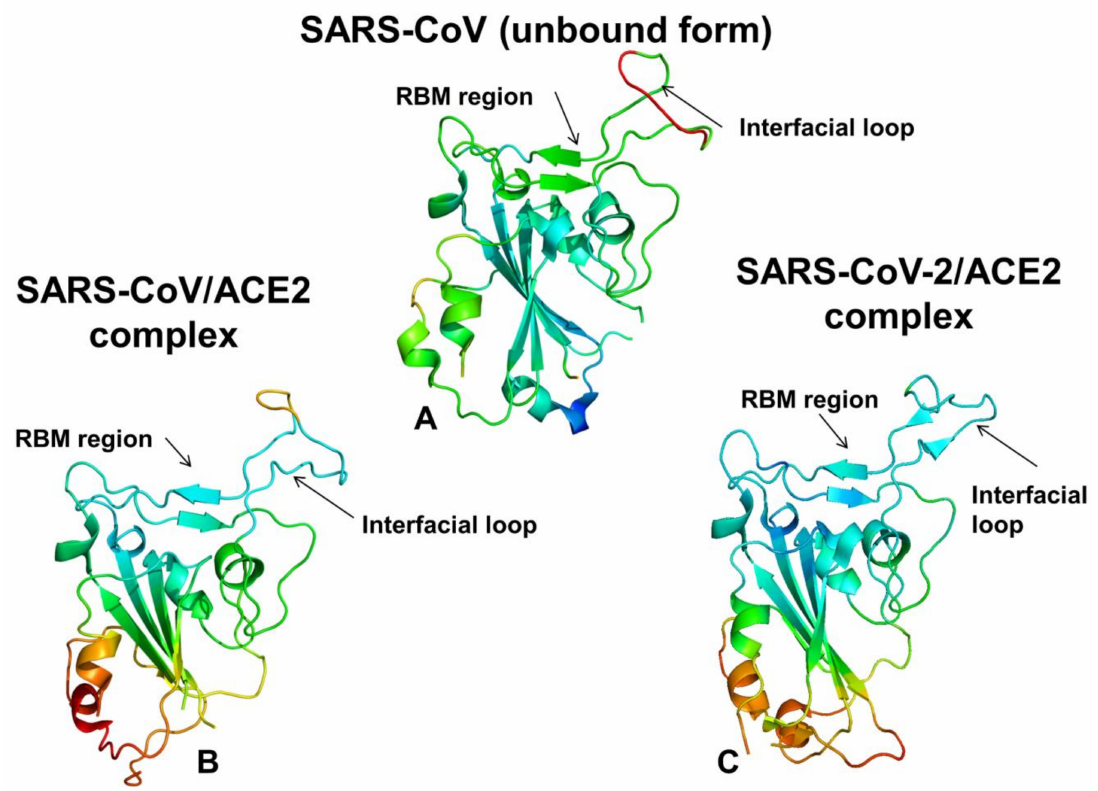
Figure 9. Structural mapping of the conformational mobility profiles in the SARS-CoV unbound structure and SARS-CoV-RBD / SARS-CoV-2 RBD complexes with ACE2 obtained from all-atom MD simulations. ( A ) Conformational dynamics profiles mapped on the unbound form of SARS-CoV-RBD (pdb id 2GHV). A ribbon-based protein representation is used with coloring (blue-to-red) according to the protein residue motilities (from more rigid-blue regions to more flexible-red regions). ( B ) Structural map of the conformational mobility profile of SARS-CoV-RBD in the complex with ACE2. The more stable regions are shown in blue and more flexible are in green-to-red coloring scale. ( C ) Structural map of dynamics profile of SARS-CoV-2-RBD in the complex with ACE2. The more stable regions are shown in blue and more flexible are in green-to-red coloring scale. For each panel, the position of the RBM region and the interfacial loop, which is an element of the RBM, are indicated with respective arrows. Note the redistribution of conformational mobility between the unbound and bound forms for SARS-CoV and